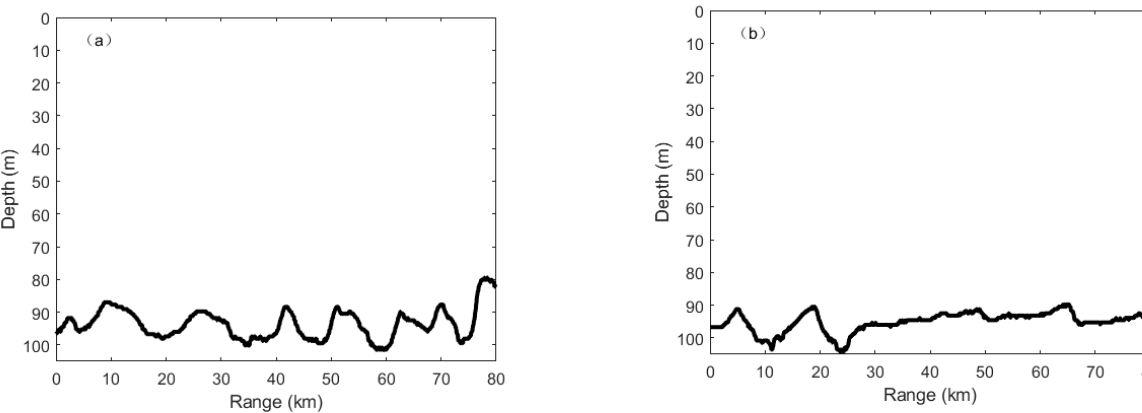
Figure 1. Configuration of the experiment.